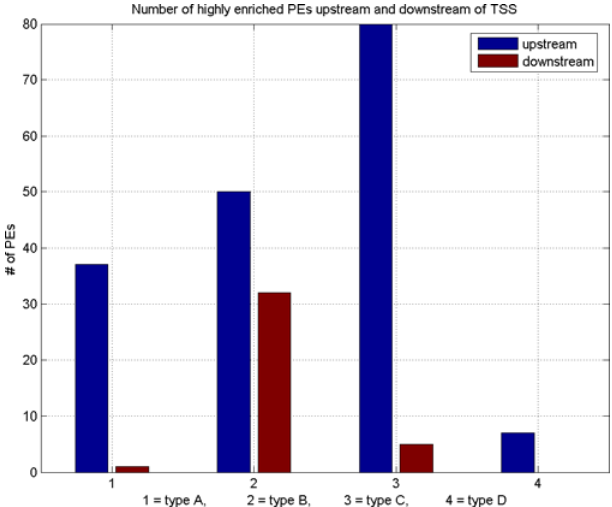
Figure 4. Distribution of Selected Groups of PEs That Are Highly Enriched (at Least 3-Fold) Upstream or Downstream of the TSS The upstream region considered covers [ (cid:2) 100, (cid:2) 1], while the down- stream region covers [ þ 1, þ 100] relative to the TSS. In all TSS types, the upstream region contains significantly more enriched PEs than the downstream